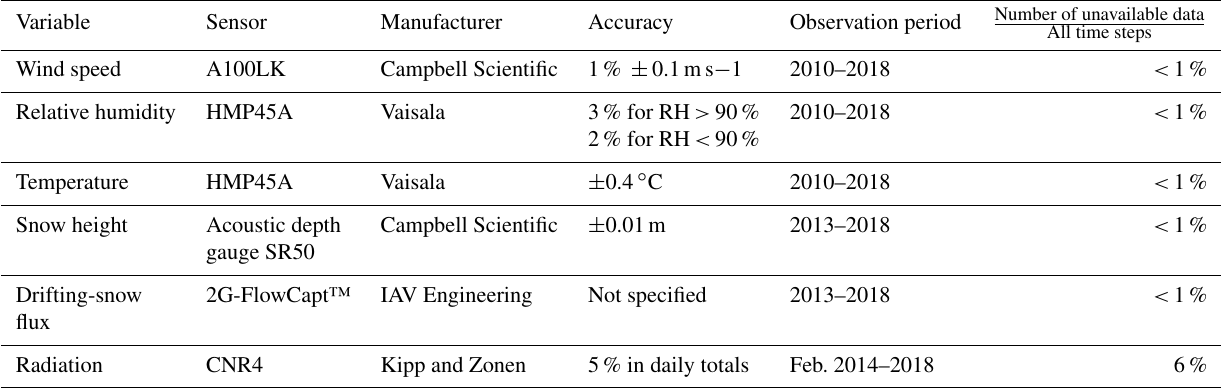
Table 1. Observed variables and technical specifications for the sensors used at